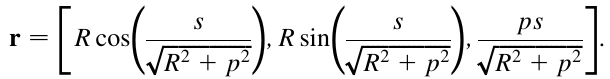
right -handed rotation. While the handedness tensor describing high-Reynolds-number flow past an object does not arise from the summation of a local-handedness density, we note that some of the properties described above have counterparts in this setting. In particular, we observe that this surfacelike object displays two opposite notions of handedness along different directions. handed response is observed is optical activity [19,24].